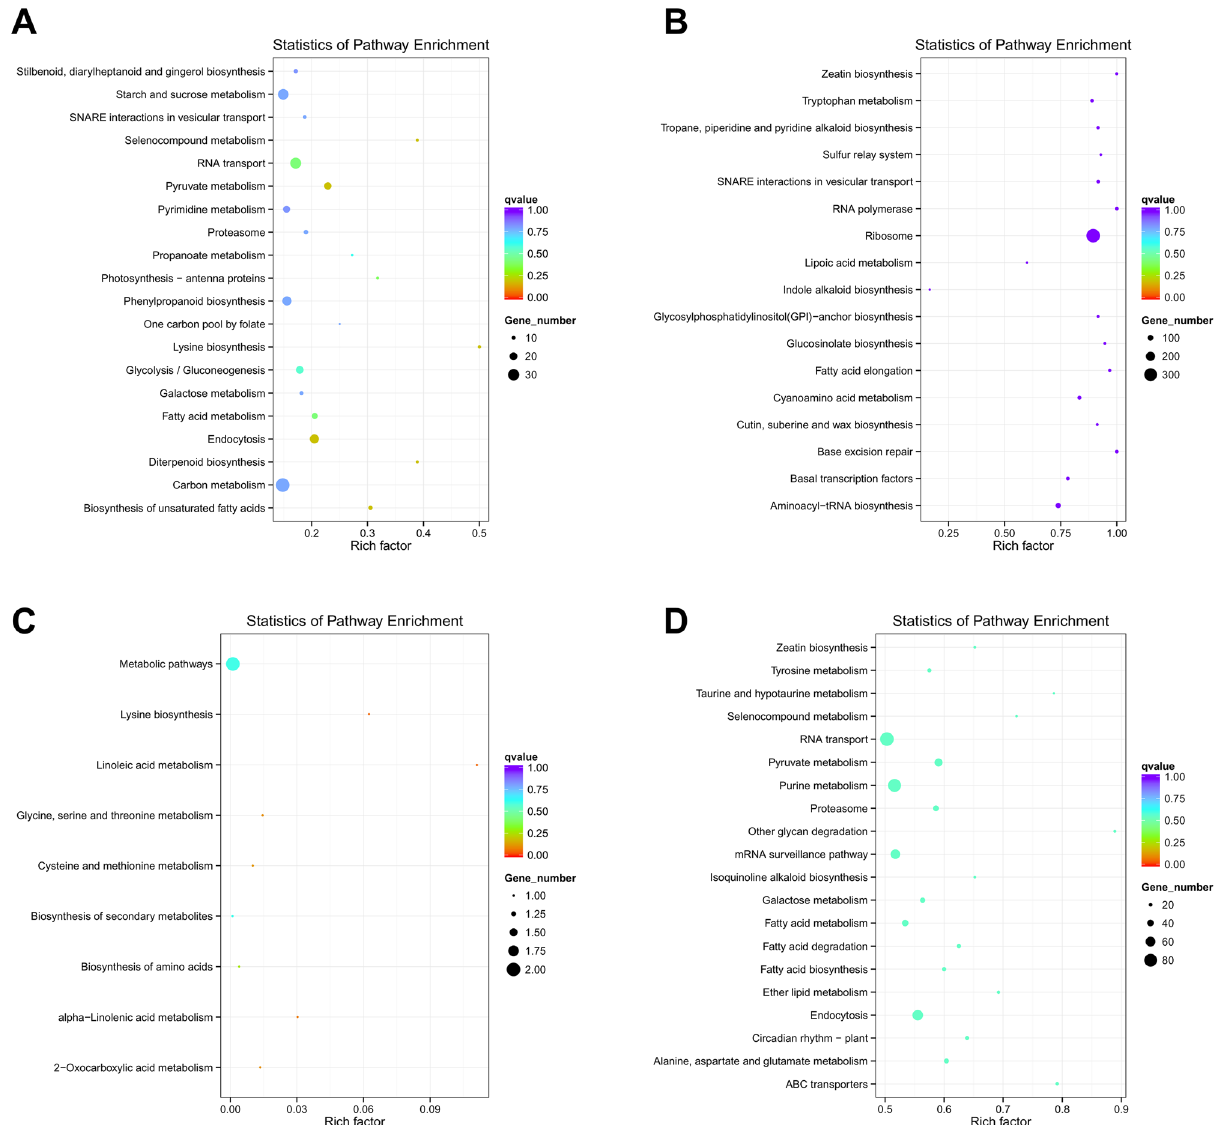
Figure 9. Scatter plot of KEGG pathway enrichment results for differentially expressed ncRNAs target genes. ( A ) Co-location of lncRNA; ( B ) expression correlation of lncRNA; ( C ) circRNA; ( D ) miRNA. Image generated with R 3.6.3 (https:// www.R- proje ct. org) 51 ggplot2 package (https:// ggplo t2. tidyv erse.